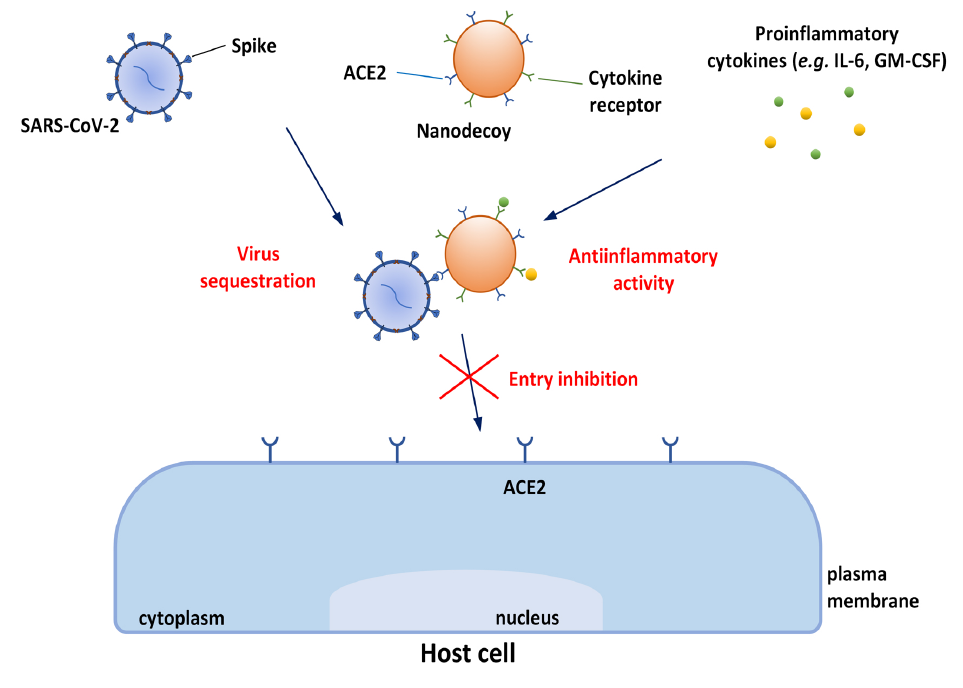
Figure 14. Cytomimetic nanosystems are innovative materials in the fight against COVID-19. The present figure is a schematic representation of the nanodecoy projected by Rao et al. [181]